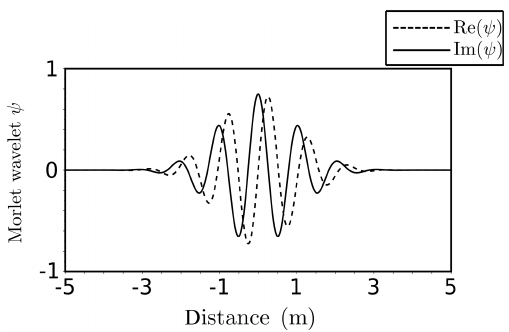
Figure 4. The wavelet Morlet mother function; the plot shows the real and imaginary parts of the wavelets in the space domain (dis-